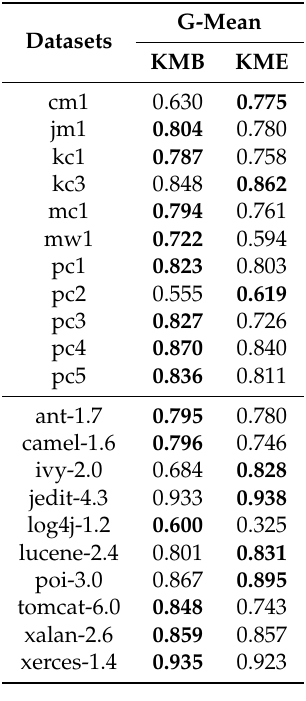
Table 7. G-mean for KMB and